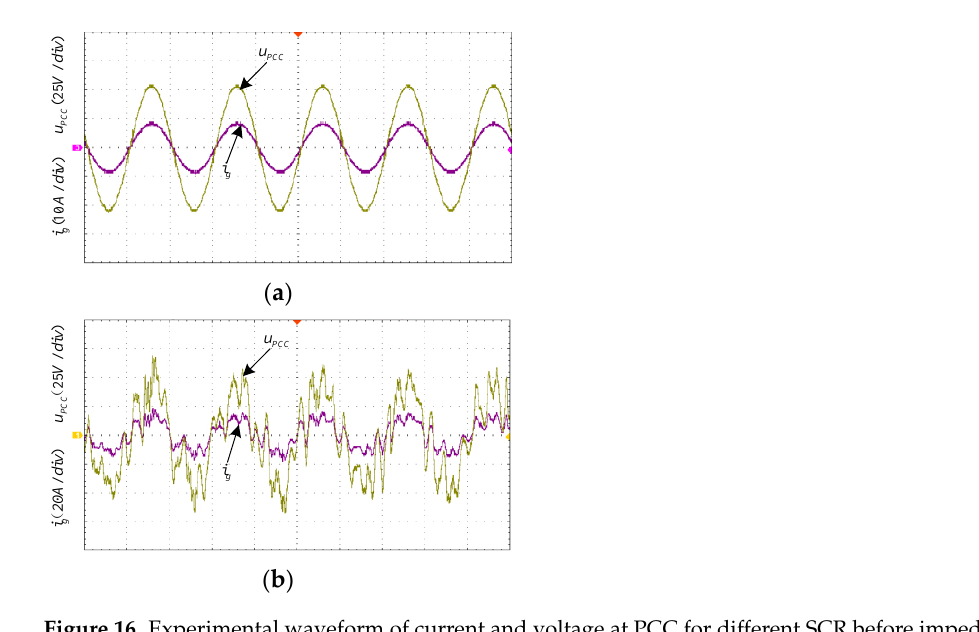
ance reshaping: ( a ) L g = 0 (SCR > 10); ( b ) L g = 10 mH (SCR = 3). reshaping: ( a ) L g = 0 (SCR > 10); ( b ) L g = 10 mH (SCR = 3).